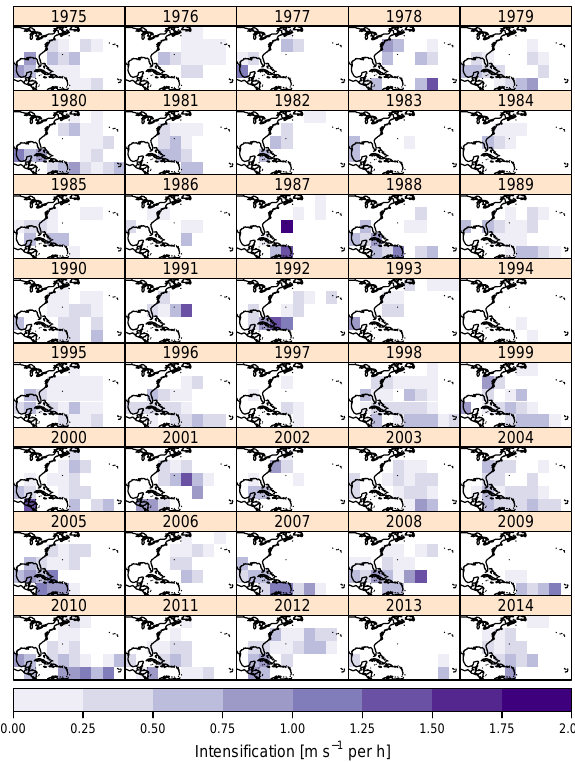
Figure 4. Yearly mean intensification rates for intensifying hur- ricanes. Mean intensification is calculated over the period June– October for each year 1975–2014.